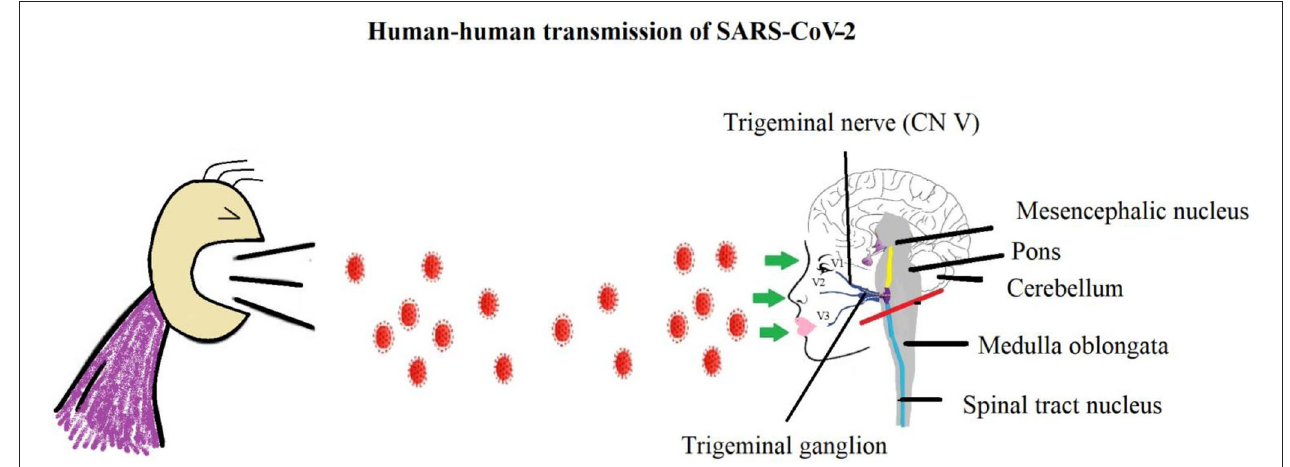
FIGURE 1 | SARS-CoV-2 transmission from one human to another and Trigeminal innervation in ophthalmic, maxillary, and mandibular